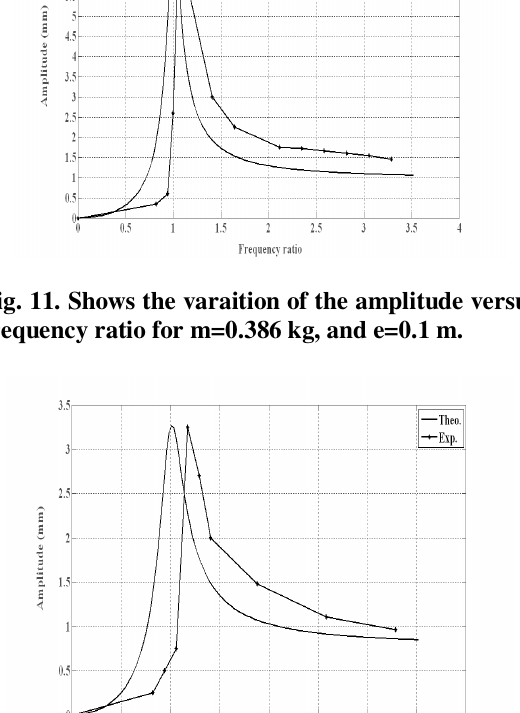
Fig. 8. Shows the variation of the amplitude versus frequency ratio for m=0.182 kg, and e=0.12 m .